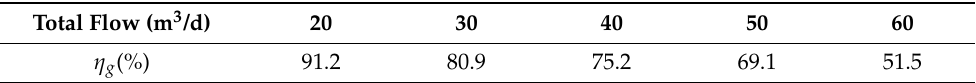
Table 3. Gas-water separation efficiency at gas holdup